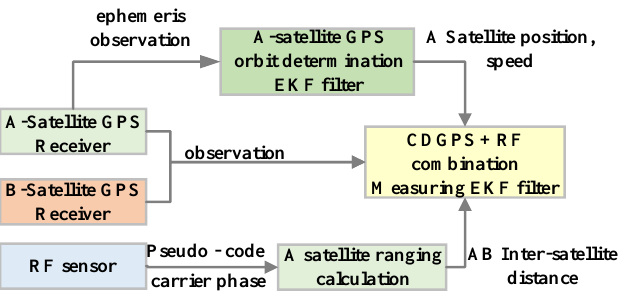
Figure 23. Schematic diagram of the GPS + RF combined relative state measurement.